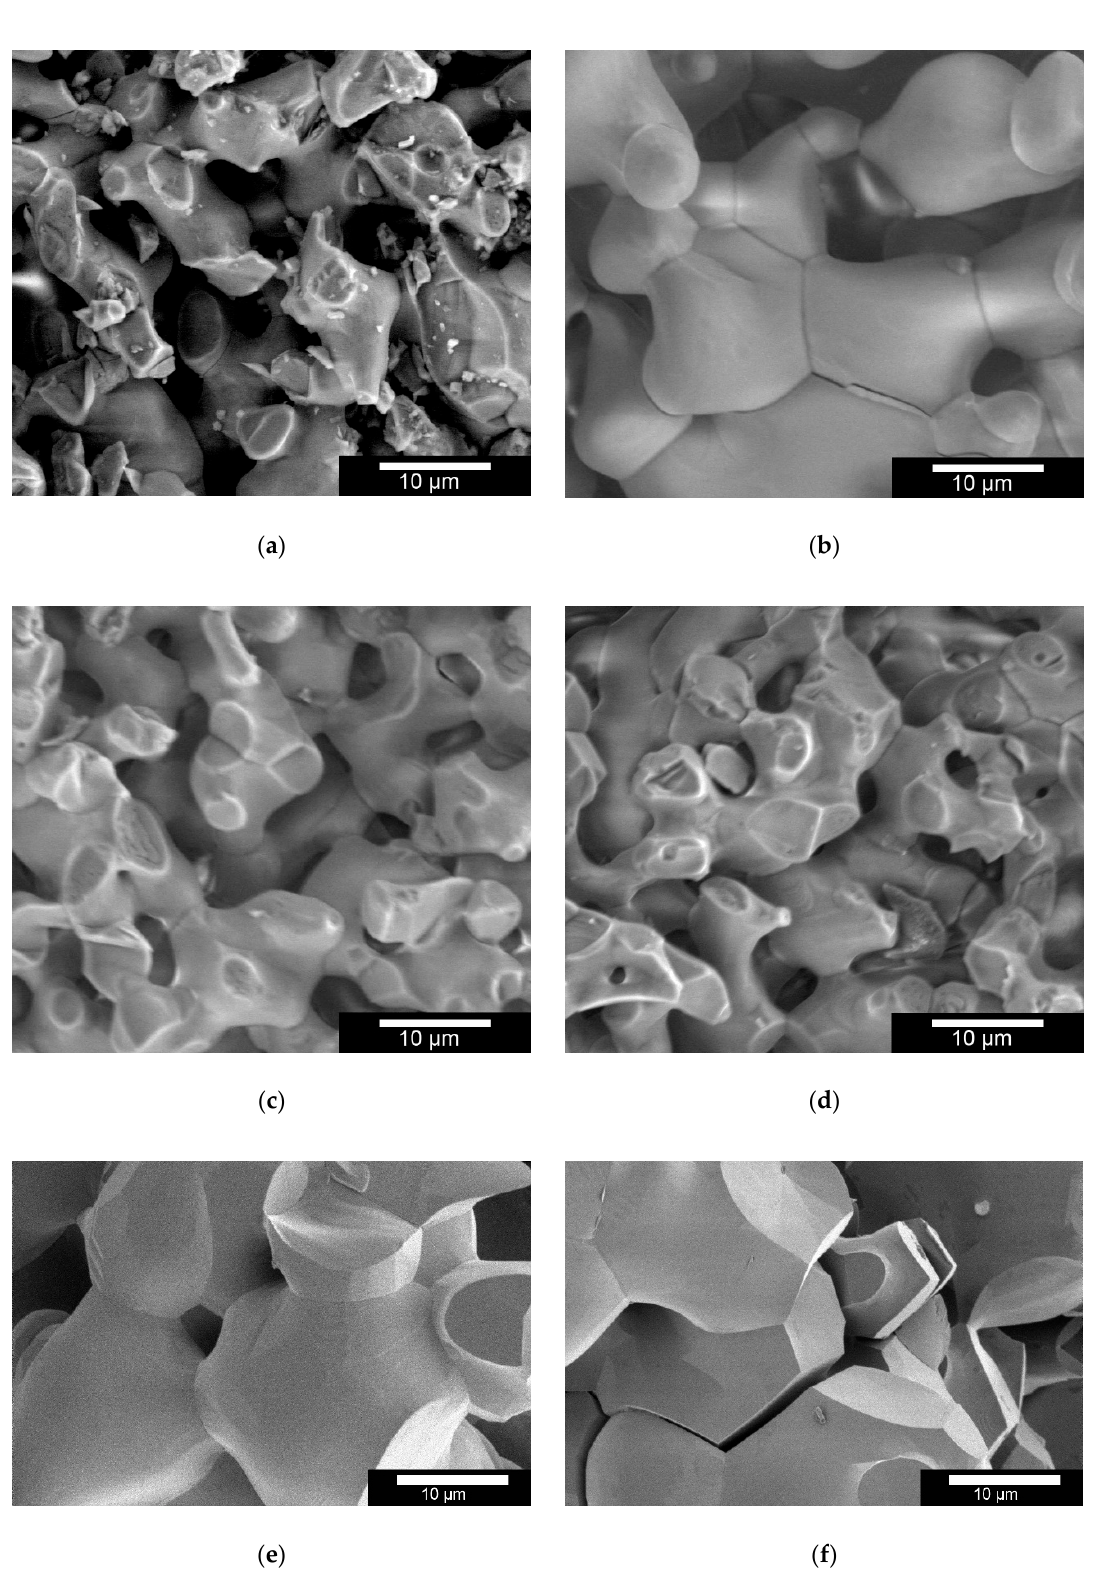
Figure 1. ESEM images of ( a ): Robert Mathys Foundation (RMS) and ( b ): Curasan β -TCP Ceramics; ESEM images of RMS Ceramics in TRIS buffer: ( c ): pH 5.0; ( d ): pH 7.4; Curasan Ceramics in TRIS buffer: ( e ): pH 7.4; ( f ): pH 5.0; Images were taken with an FEI Quanta 250 FEG and ( e , f ) FEI Scios, acceleration voltage 10 kV, HFW of 46.6 µm.